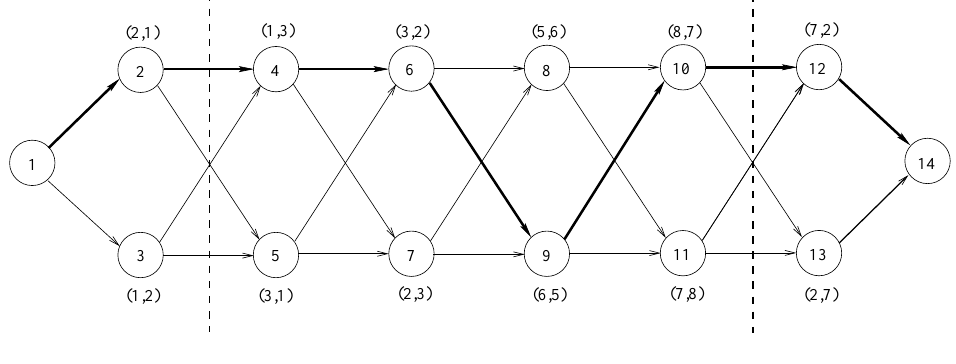
Figure 3: The layered graph, L 4 , corresponding to the solution sequence S 4 = h (2 , 1) , (1 , 3) , (3 , 2) , (5 , 6) , (8 , 7) , (7 , 2) i . A shortest path from the first to the last layer is shown using bold edges.